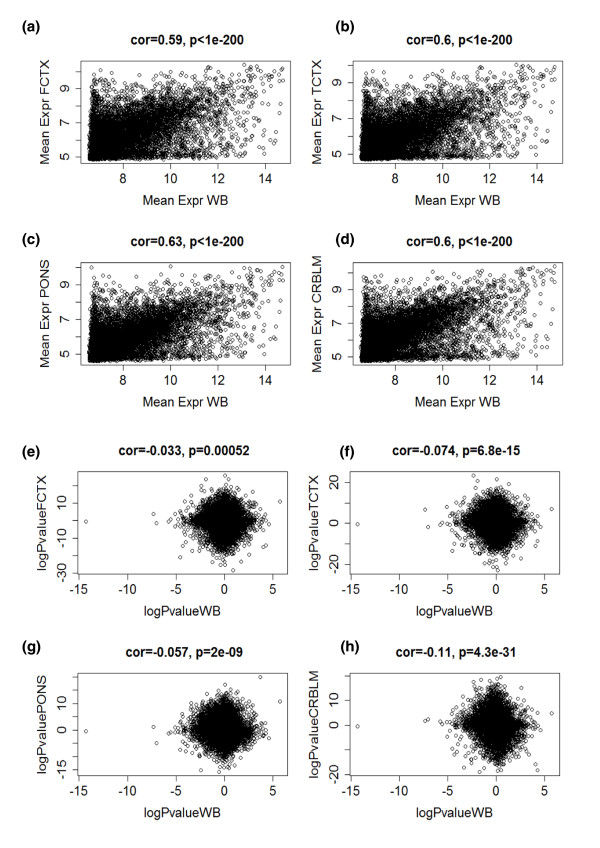
Age effects on gene expression (mRNA) levels are not preserved between blood and brain tissue. (a-d) Scatterplots of mean gene expression (mRNA abundance) in whole blood of the Dutch samples (x-axis) and corresponding mean brain expression values (y-axis) for frontal cortex (FCTX) (a), temporal cortex (TCTX) (b), pons (c), and cerebellum (CRBLM) (d). Each dot corresponds to a gene. The brain mRNA data (like the brain methylation data used in this article) were obtained from [19]. Note that only moderate correlations (around r = 0.6) exist between the mean expression values of these distinct tissues. (e-g) Overall age correlations of gene expression levels (mRNA) are not preserved between blood (x-axis) and brain tissues (y axes) as evidenced by the weak negative correlations reported in the title of each panel. The mRNA levels of each gene (represented by a dot) were correlated with subject age and a linear regression model was used to calculate a correlation test P-value. The x-axis of each scatterplot shows the (signed) logarithm (base 10) of the correlation test P-value in blood. Genes with a significant positive (negative) correlation with age have a high positive (negative) log P-value. The y-axis shows the corresponding correlation test P-values in the frontal cortex (e), temporal cortex (f), pons (g), and cerebellum (h).